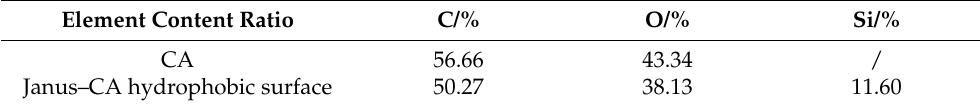
Figure 14. EDS analysis: ( a , b ) CA fiber; ( c , d ) Janus–CA fiber. Table 1. CA and Janus–CA fiber surface element weight percentage.